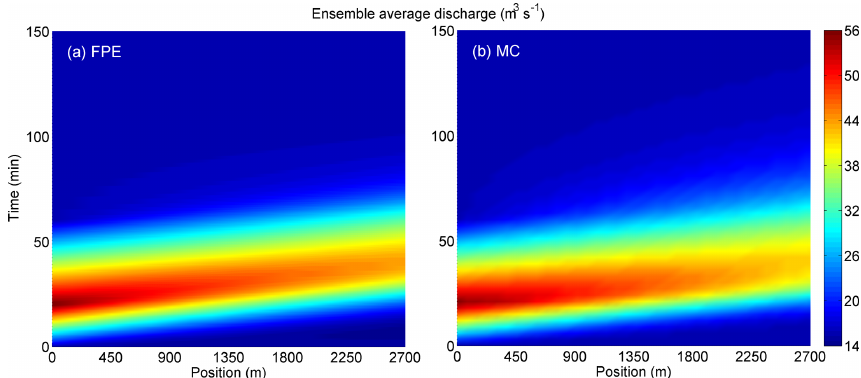
Figure 1. Ensemble average discharge over channel position and time obtained by (a) the FPE methodology and (b) the MC approach.